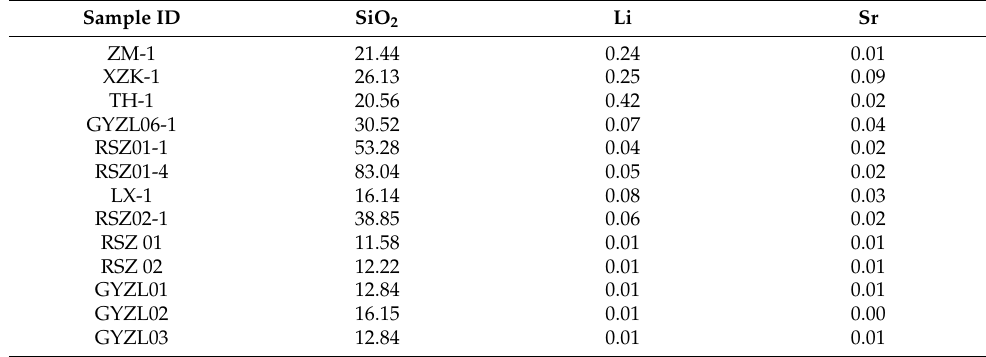
Table 2. Trace element concentrations for thermal and non-thermal wells and river water samples for Suichuan County. Units used as